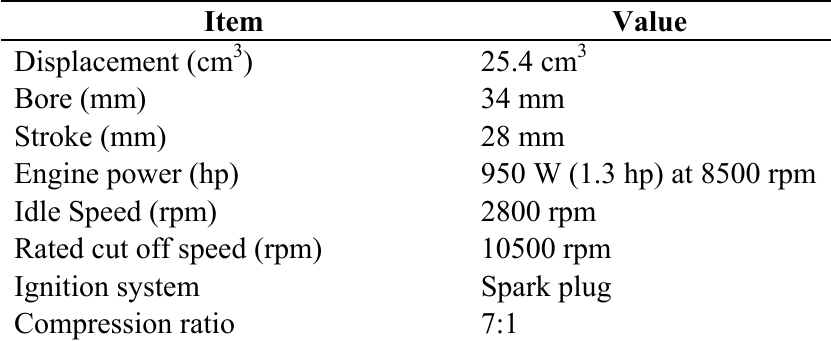
Table 1. Single cylinder two stroke engine (KM 85)